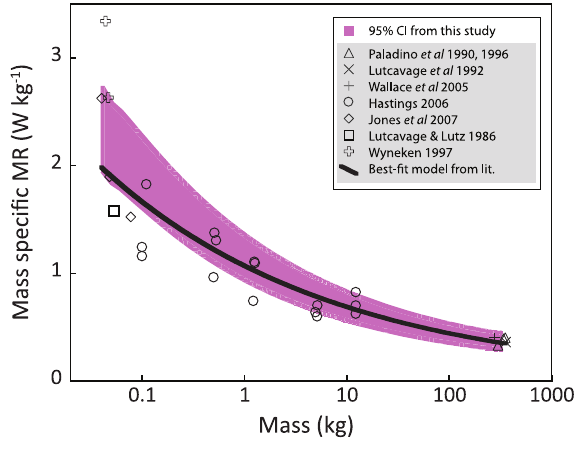
Figure 3. Metabolic rate (MR) (W kg 2 1 ) determined from food consumption this study (pink shaded area) plotted with metabolic rates of leatherback hatchlings, juveniles, and adults from the literature (symbols). Pink shaded area is the 95% CI estimated from the variability in parameters b (food conversion constant), b (scaling exponent), and k (growth parameter), see Figures 1 and 2. Black solid line is the best-fit model through the literature MR values (given by